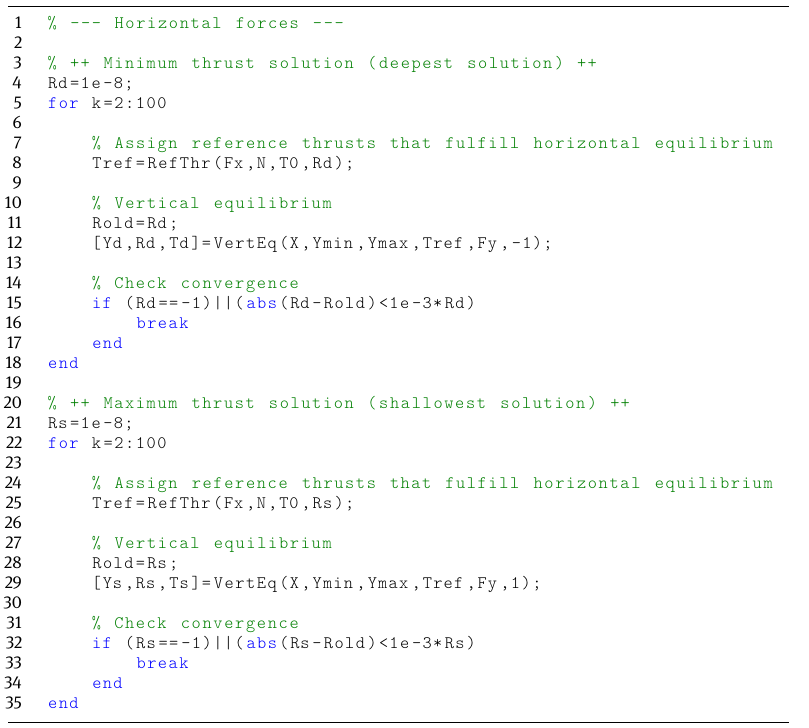
Figure 5: Solving procedure in presence of horizontal forces. The code of functions VertEq and RefThr are reported in Figure 4 and 6,